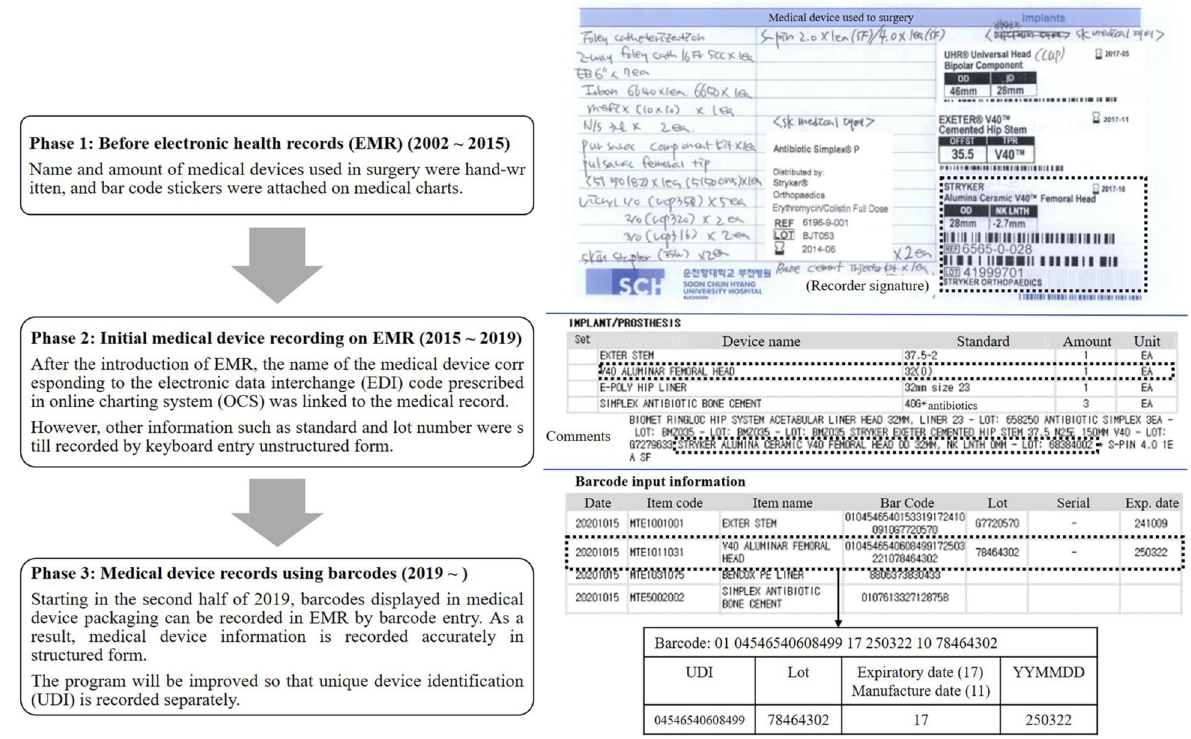
Figure 3. Changes of implanted medical device records in our institution.